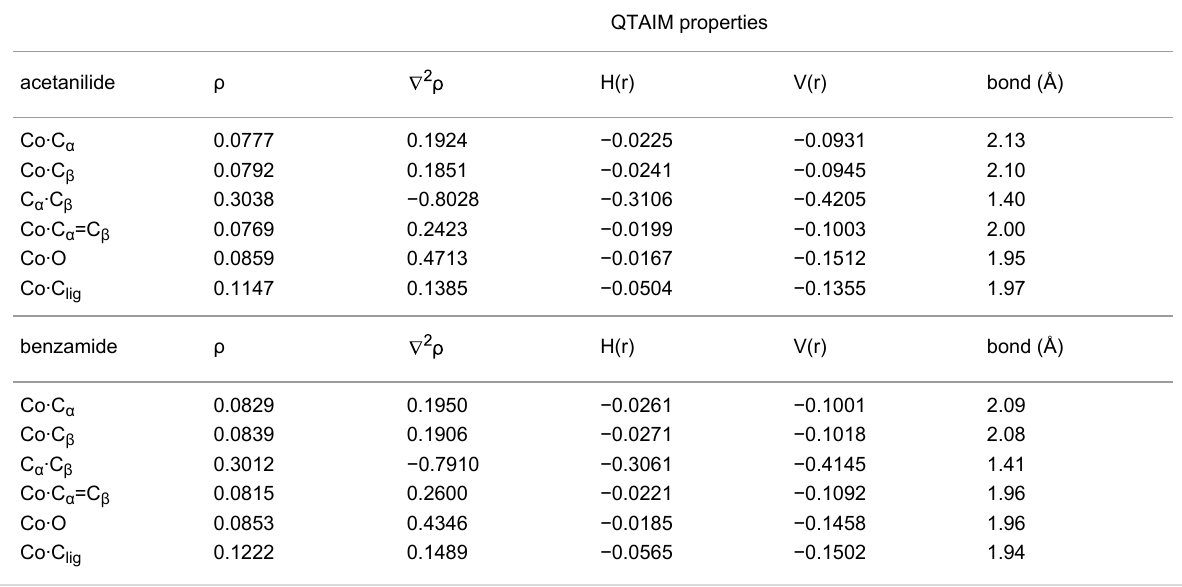
Table 1: QTAIM and structural parameters for Int 2 ketone with the acetanilide and benzamide substrates.